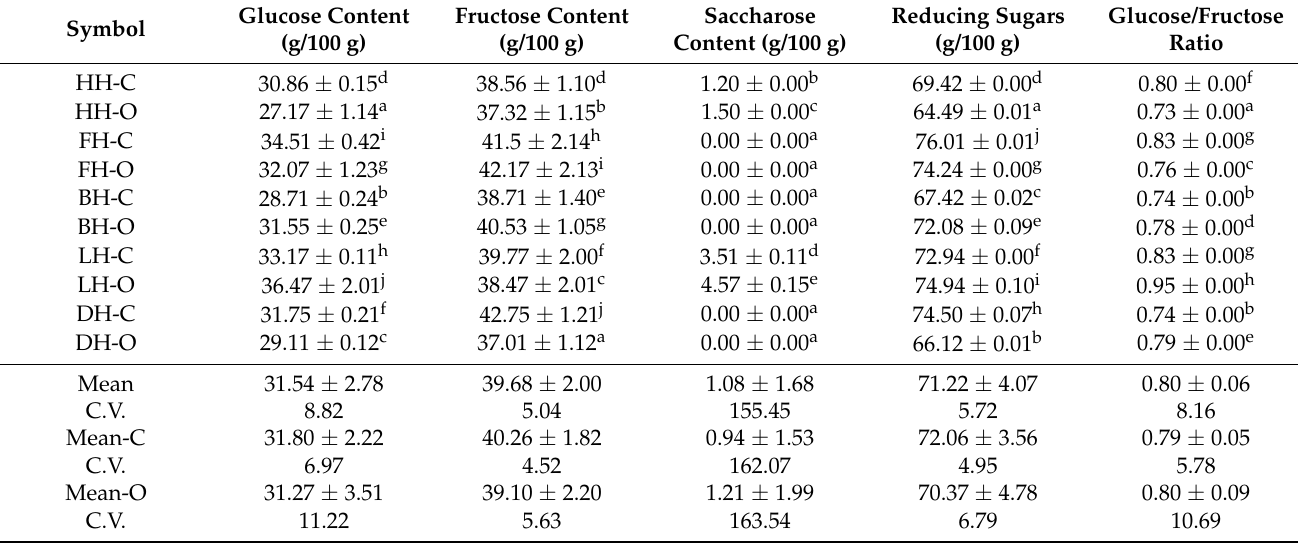
Table 2. Sugar profile in honey samples (mean value and standard